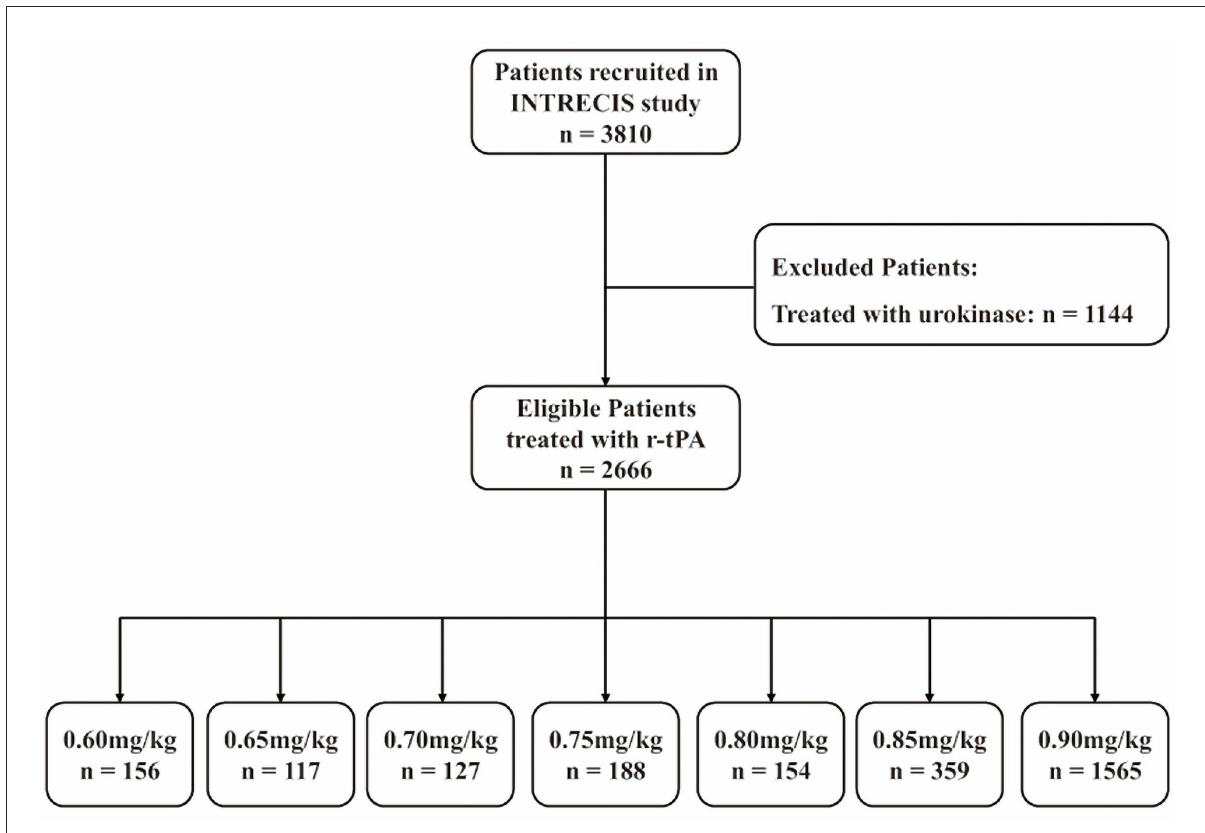
FIGURE1 Flow diagram. r-tPA, recombinant tissue plasminogen activator; INTRECIS, INtravenous Thrombolysis REgistry for Chinese Ischaemic Stroke within 4.5h of